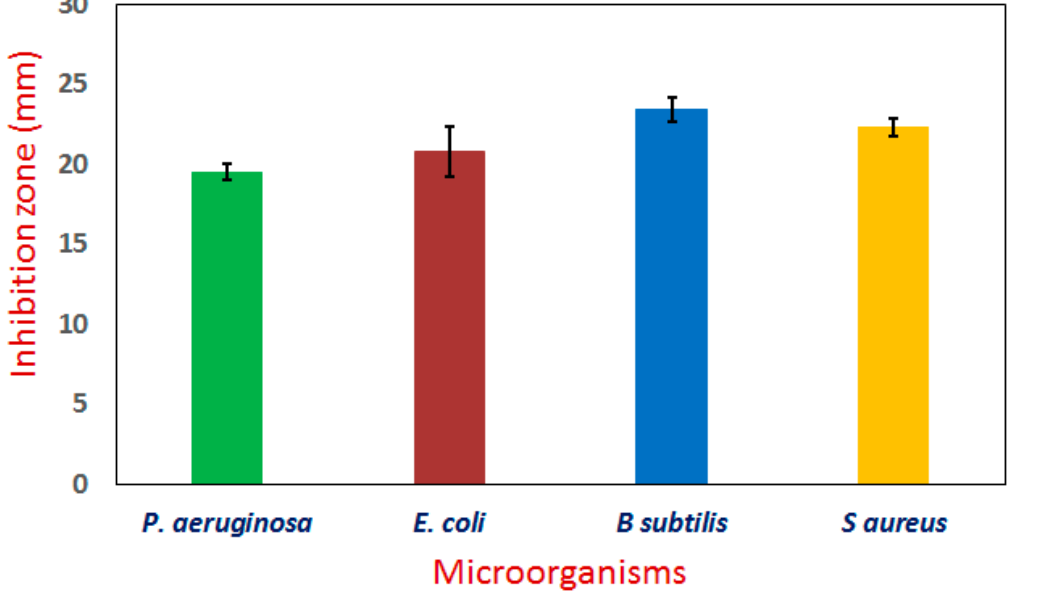
Figure 7. Antimicrobial activity of the synthesized Ag/Fe 2 O 3 by Buddleja lindleyana extract.